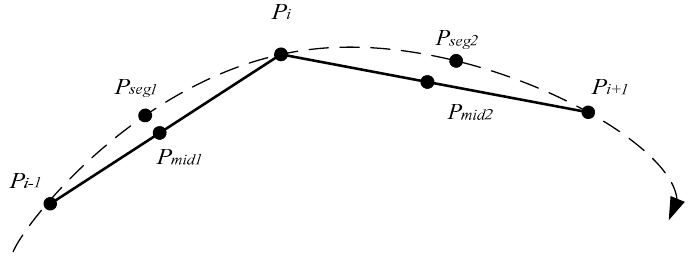
Figure 3. A Proxy of a natural sub-trajectory.